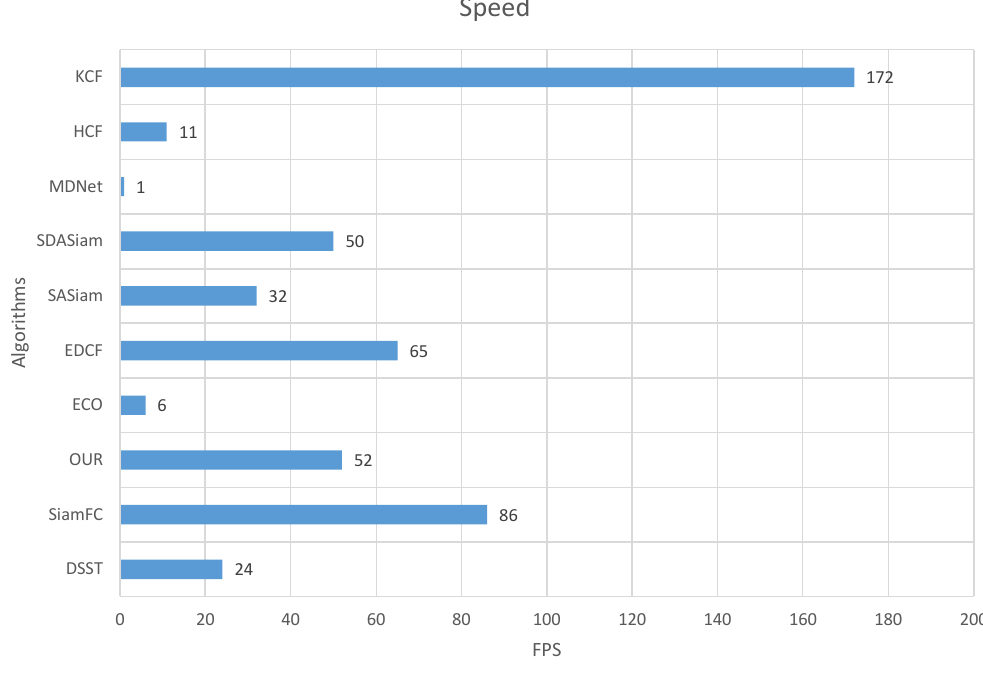
Figure 11. Comparison of speed performance of different